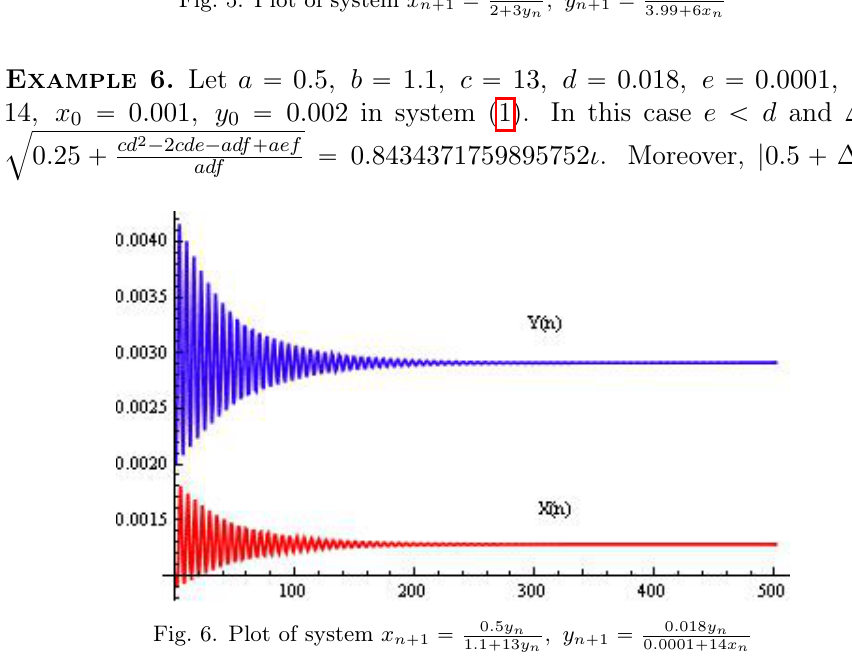
Fig. 5. Plot of system x n ` 1 “